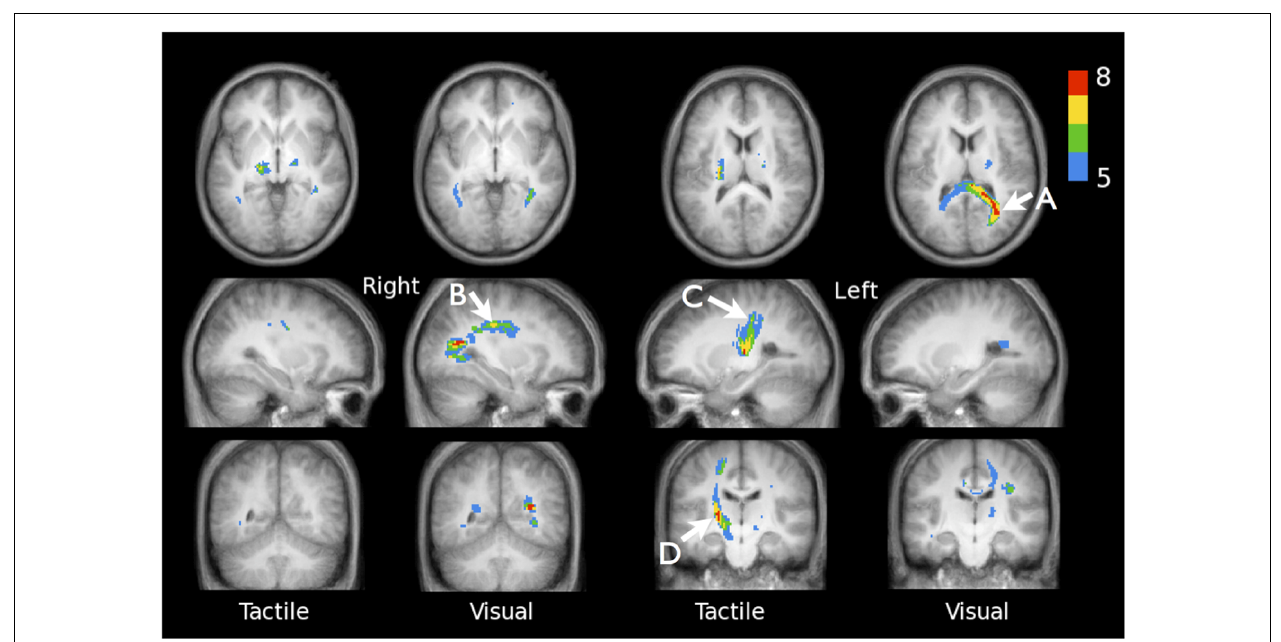
FIGURE 4 |Accumulated fDTI results of all 12 individuals for the tactile and visual tasks. For both tasks the cumulative fDTI results were computed and overlaid on the subjects’ average anatomy. The value of a (colored) voxel represents the minimum number of subjects for which active fibers are found at that position. Visual activation is found for tracts that are part of the forceps major (A) MNI-coordinate